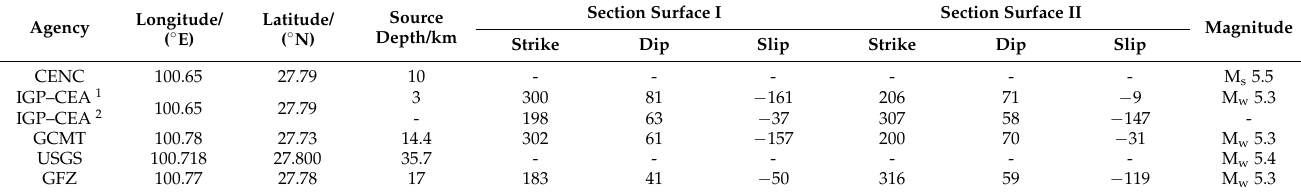
Table 1. The focal mechanism solutions of the Ninglang earthquake on 2 January 2022 given by different institutions. (Institute of Geophysics of the China Earthquake Administration, IGP-CEA [53]; Global Centroid-Moment-Tensor, GCMT [54]; United States Geological Survey, USGS [55]; Helmholtz Centre Potsdam—German Research Centre for Geosciences, GFZ [56]).